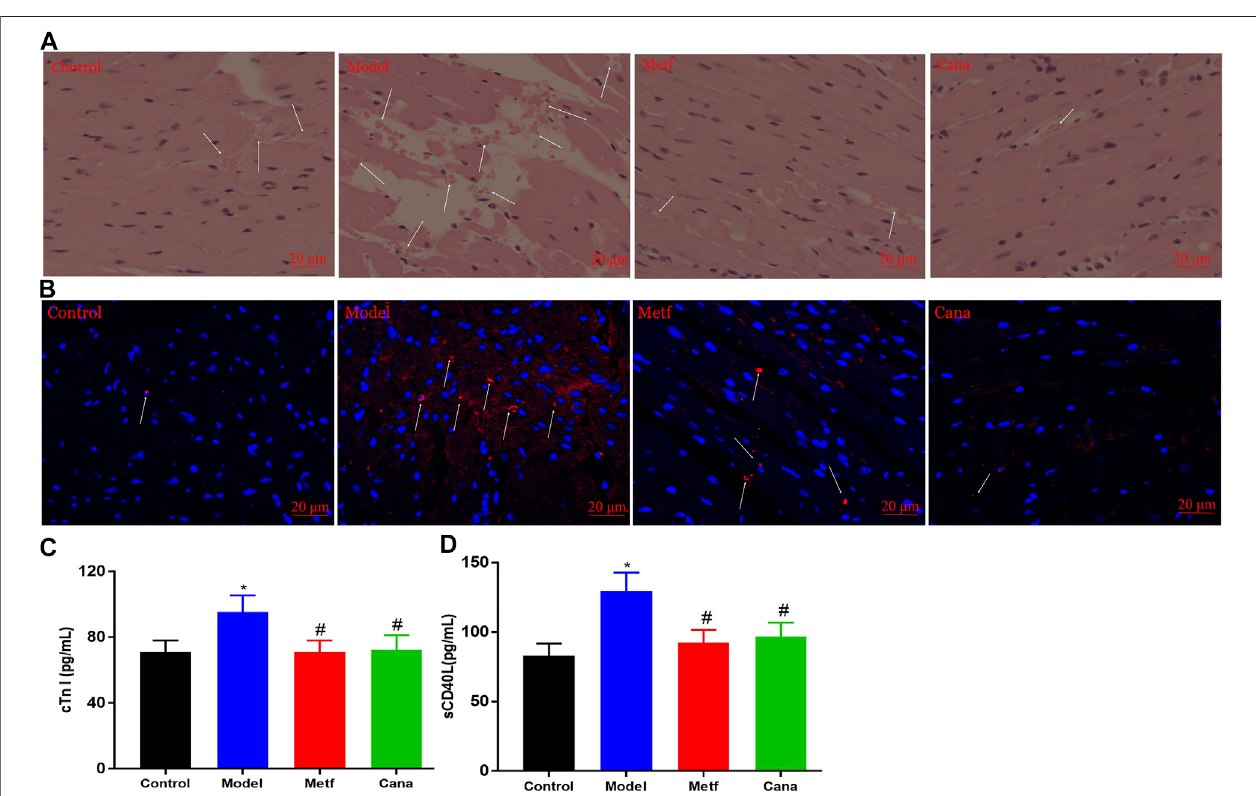
FIGURE 4 | Effects of Cana on improving myocardial injury in T2DM mice. H&E staining in cardiac tissues (A) . TdT-mediated fl uorescein nucleotide (cyanine 3- dUTP) nick-end labeling (TUNEL) assay to detect apoptosis in cardiac tissues (B) , blue represents nucleus, while red represents fragmented DNA, scale bar: 20 μ m. Levels of cardiac troponin 1 (cTn I) (C) and soluble cluster of differentiation 40 ligand (sCD40L) (D) in serum. & p < 0.05, the Cana group compared with the Metf group; # p < 0.05, compared with the model group; * p < 0.05, compared with the control group. Six mice in each group were randomly selected for